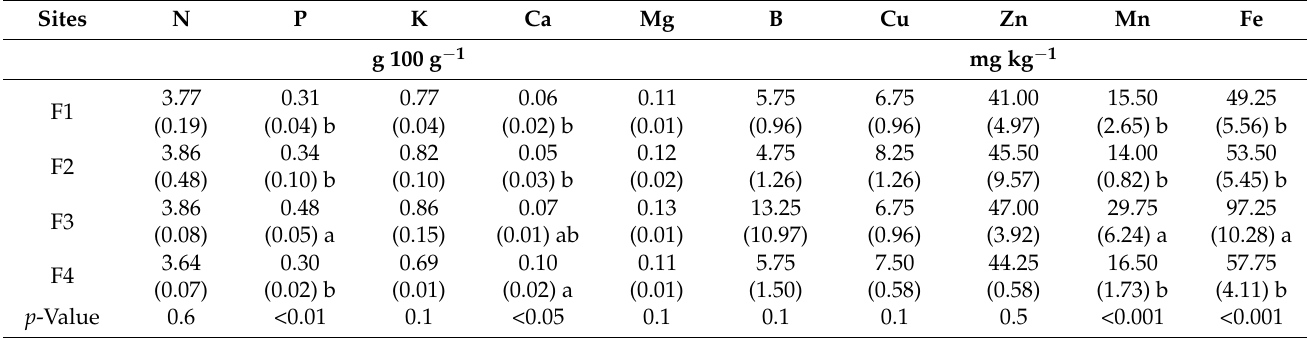
Table 3. Nutrient concentration of lentil grains cultivated in Chanco town, Maule region, central Chile. The p -value was obtained after ANOVA test. The small letters indicate statistical differences among sites according to Tukey test ( p < 0.05) and SD is presented in